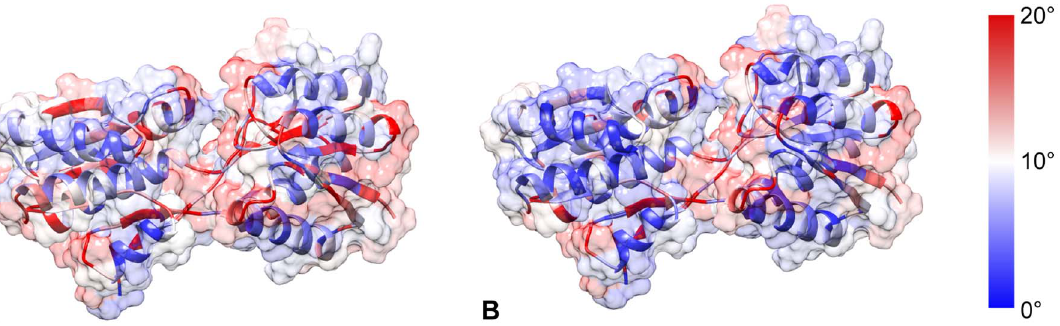
Figure 5. Plot of active DOF s for expert (A) and auto (B) experiments. Color bar indicates cumulative per-residue torsional change over the entire determined transition. The two experiments show comparable activity in torsional DOF s, largely confined to central loops through which much of the bending occurs.